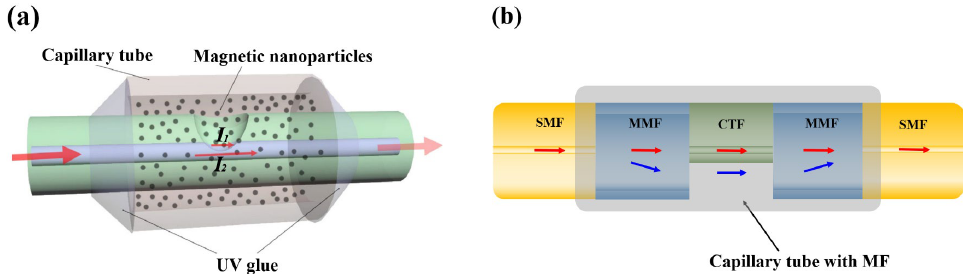
Figure 3. Magnetic field fiber sensors based on the open-cavity structure with ( a ) an SMF (reprinted with permission from Ref. [38], 2022, Elsevier) and ( b ) a CTF [39].